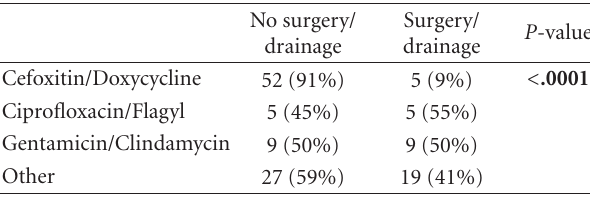
Table 4: Outcomes of surgery and drainage by initial antibiotic